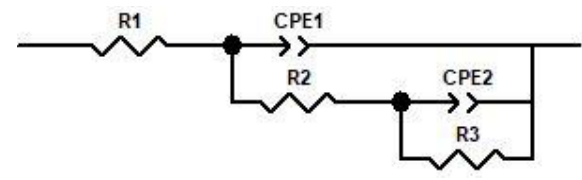
Figure 7. The equivalent electric circuit for impedance data.